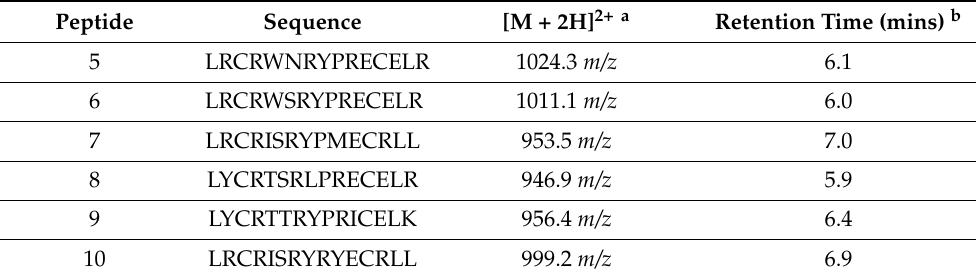
Table 4. Peptides chemically synthesised for in vitro